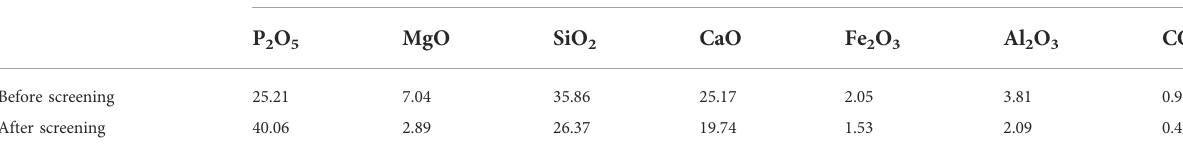
TABLE 4 The mineral composition changes before and after the crush